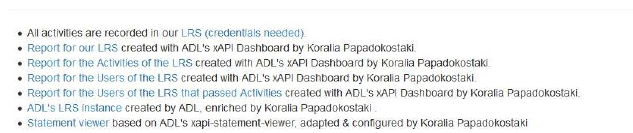
Figure 6. The user has previously completed